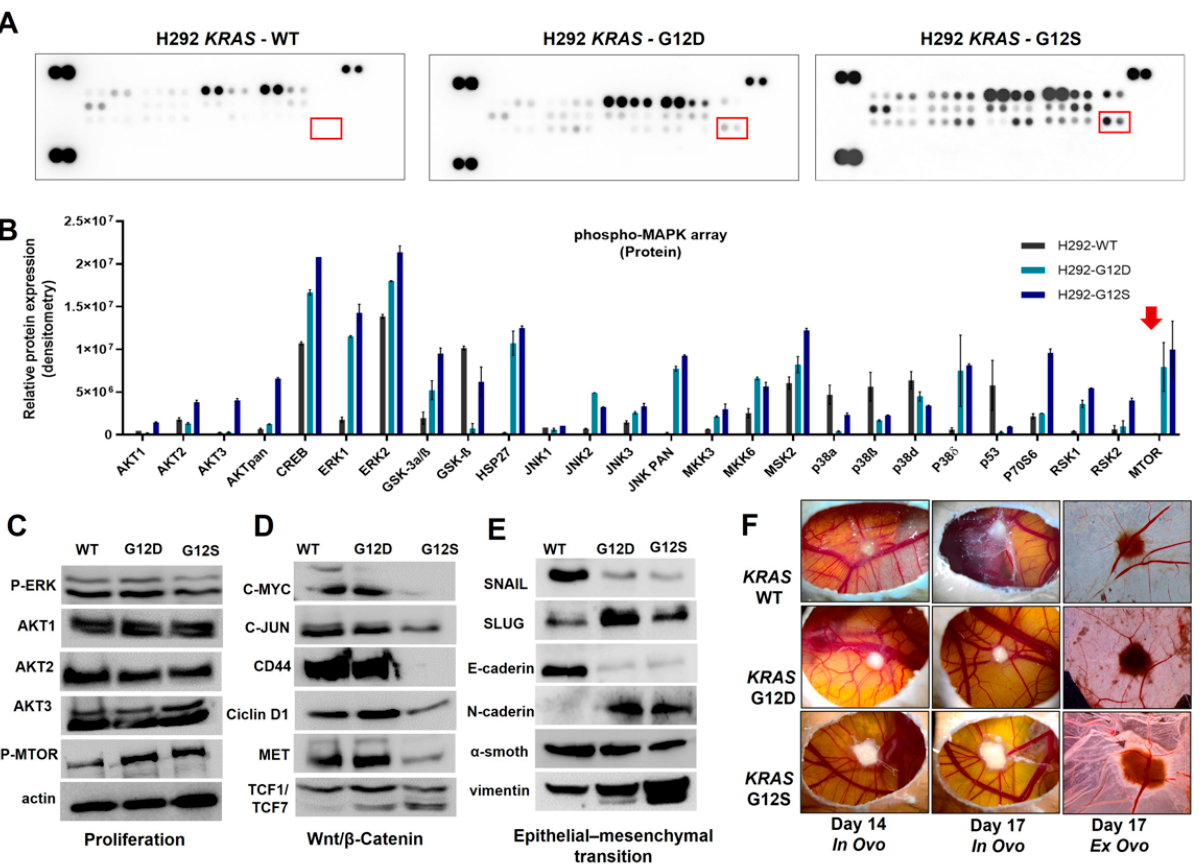
Figure 3. Molecular alterations in KRAS mutated cell lines. Representative pictures of phospho-RTK arrays for H292 KRAS wild-type, KRAS (G12D), and KRAS (G12S) cell lines ( A ). Each RTK is duplicate in the arrays (two spots side by side) and four pairs of phosphotyrosine positive controls in the corners of each array. Densitometric analyses are represented by bar graphs and red arrow show mTOR in KRAS mutated cells. Red squares show the mTOR phosphorylated levels ( B ). Analysis of proliferation markers ( C ), Wnt/ β -catenin ( D ), and epithelial–mesenchymal transition ( E ) markers by Western blot. In vivo effect of KRAS mutations on H292 cell line growth ( F ). Representative pictures (×16 magnification) of CAM assay in ovo and ex ovo at 14 and 17 days. Data presented as a mean of 18 eggs per group.